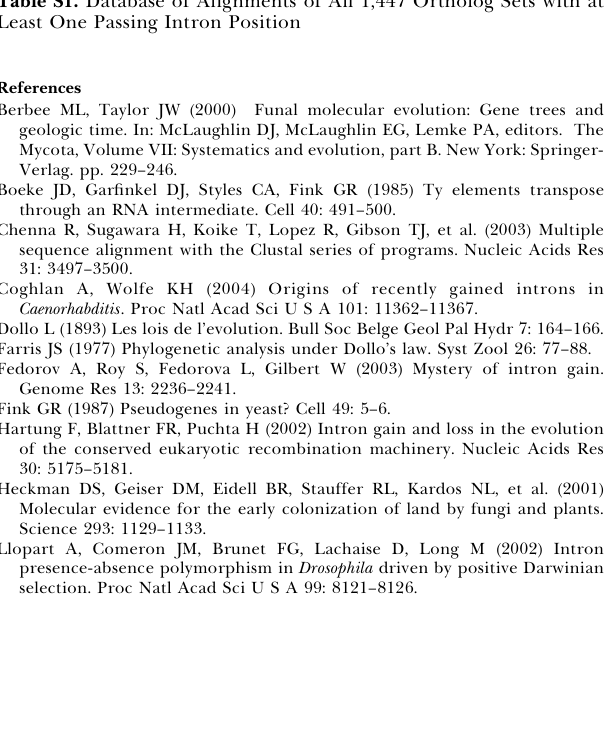
Figure S1. Intron Gains and Losses Inferred from Best-Only BLAST Hit Orthologs Positional biases in intron gain, loss, and current distribution in three fungal genomes determined using orthologs predicted by a ‘‘ bidirec- tional only hit ’’ method. (A), (B), and (C) are roughly analogous to (D), (E), and (A), respectively, in Figure 3. Found at DOI: 10.1371/journal.pbio.0020422.sg001 (78 KB DOC). Table S1. Database of Alignments of All 1,447 Ortholog Sets with at Least One Passing Intron